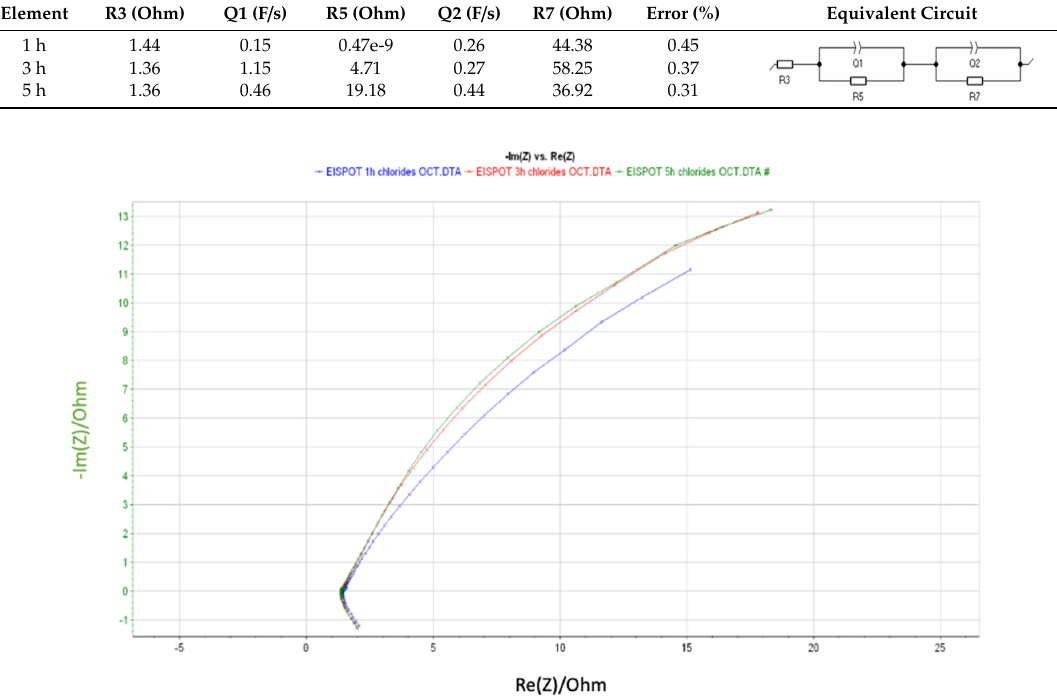
Table 4. Electrochemical parameters obtained from EIS tests of OCI alloy. Figure 6. Micrographs showing a top view ( left ) and a cross section ( right ) of OCI immersed in ternary chloride molten salt for 8 h at 720 °C; EDX analysis is shown on top.